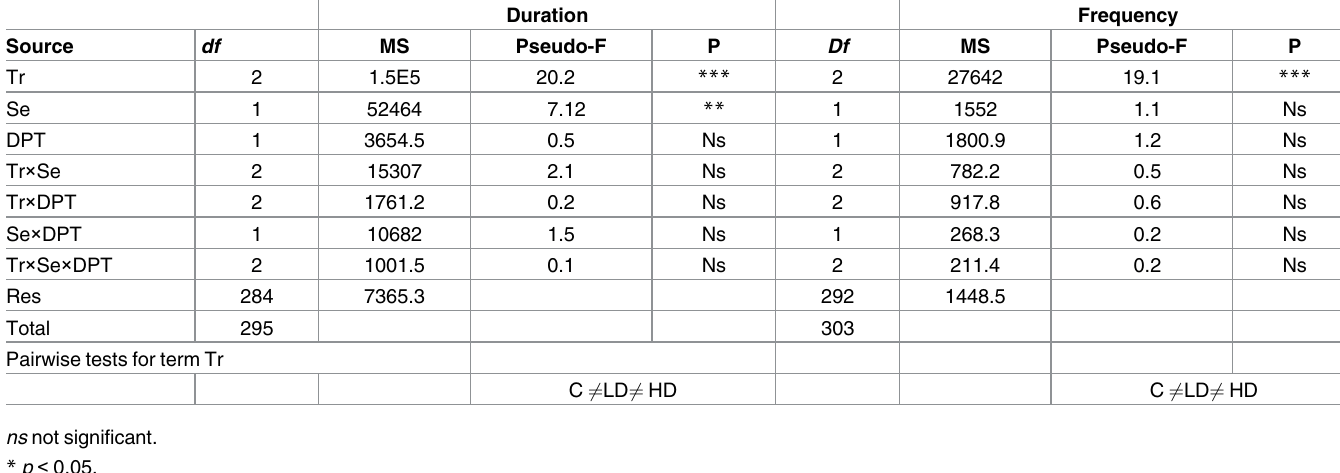
Table 1. Permutational multivariate analysis of variance. PERMANOVA analyzingdifferences in behavioral responses measuredas durationand fre- quency amongfish feedingfood treated with caulerpin at low and high dose and controls. Differencesare basedon Euclideandissimilarities of untransformed data. Each test was conductedusing 4999 permutations of appropriate units. Analyseswere performed with Type III (partial) sum of squares. Results of pair- wise tests for the significantterm treatment (Tr) are reporteddown in the